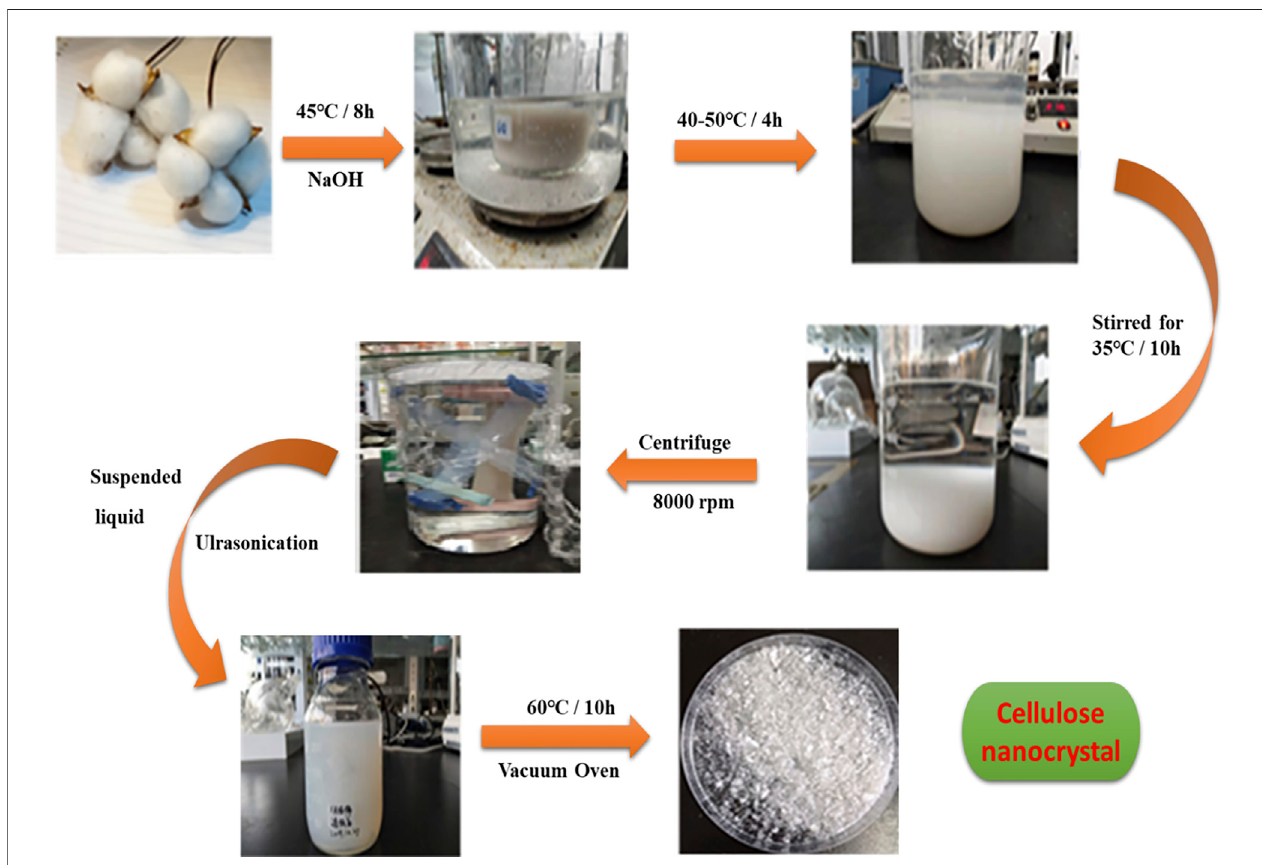
FIGURE 1 | Schematic illustration of the preparation of CNCs from cotton. The alkaline treatment of cotton fi bers at elevated temperature, centrifugation, ultrasonication, and vacuum oven drying resulted in the preparation of CNCs.